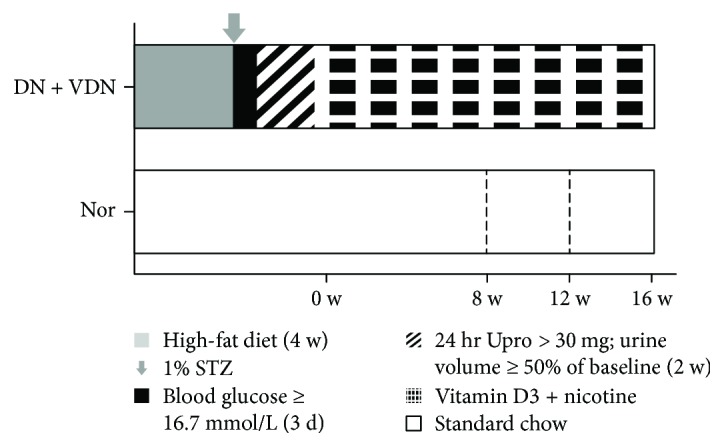
Schematic illustration of the experimental protocol. W: week; STZ: streptozotocin; Upro: urine protein. Nor group: normal controls; DN + VDN group: diabetic nephropathy rats with vitamin D3/nicotine-induced vascular calcification.